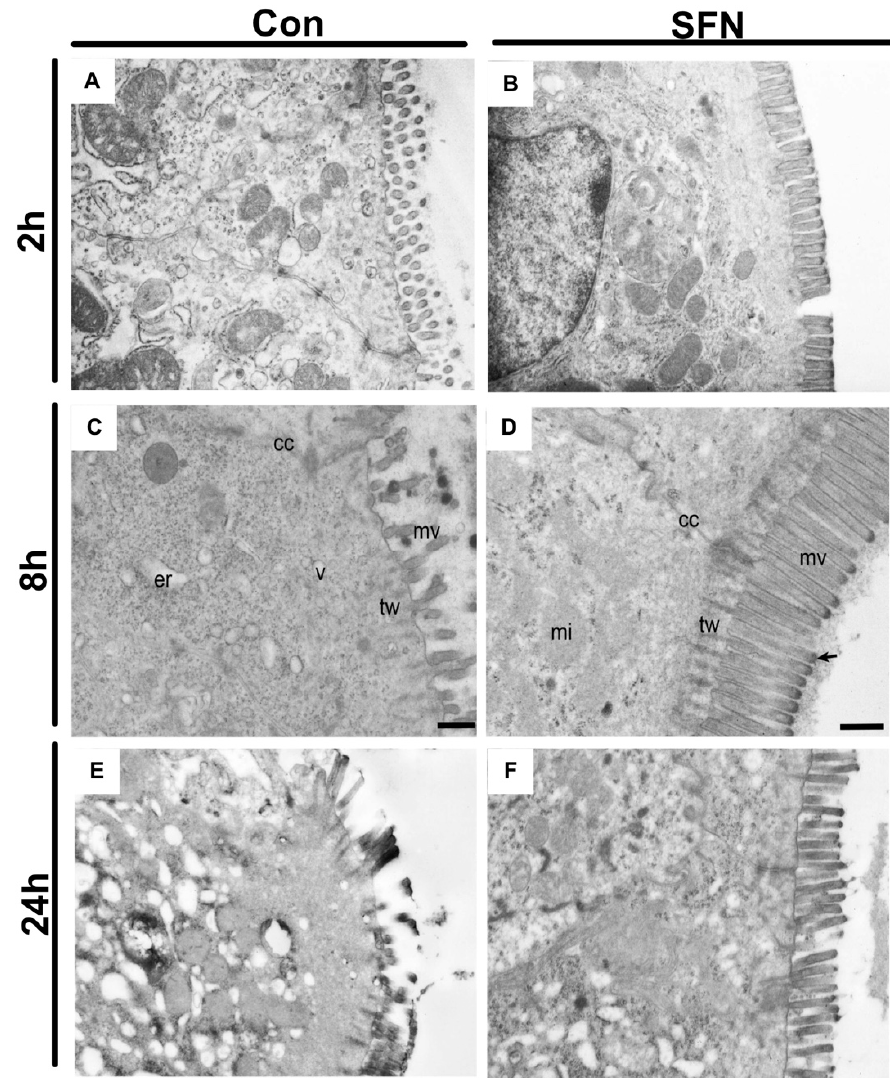
Figure 5. Representative electron micrographs of control ( A , C , D ) and SFN treated ( B , D , F ) samples after 2, 8 and 24 h of reperfusion. ( A ) In controls after 2 h reperfusion, epithelial cells exhibit altered mitochondria and an enlarged endoplasmic reticulum, while SNF treated samples exhibits an intact morphology and organization of epithelial cells ( B ). ( C ) Epithelial cell with an altered brush border with less microvilli and a disorganized terminal web. Numerous vesicles and an enlarged endoplasmic reticulum are clearly visible while cell-cell contacts are disrupted. ( D ) Epithelial cells connected by intact cell-cell contacts. Ultrastructure of the brush border and terminal web region with highly organized microvilli. Notice the actin filaments that descend from the electron dense tip (arrow) of the microvillus into the underlying terminal web. ( E ) A strongly a ff ected brush border is clearly visible after in control samples after 24 h reperfusion, which is absent in SFN treated animals, showing an intact morphology and organization of epithelial cells ( F ). Images are representative of n = 10 analyzed animals per group and timepoint. cc = cell-cell contact; mi = mitochondria; mv = microvilli; tw = terminal web; er = endoplasmic reticulum. Scale bar for all images: 500 nm.